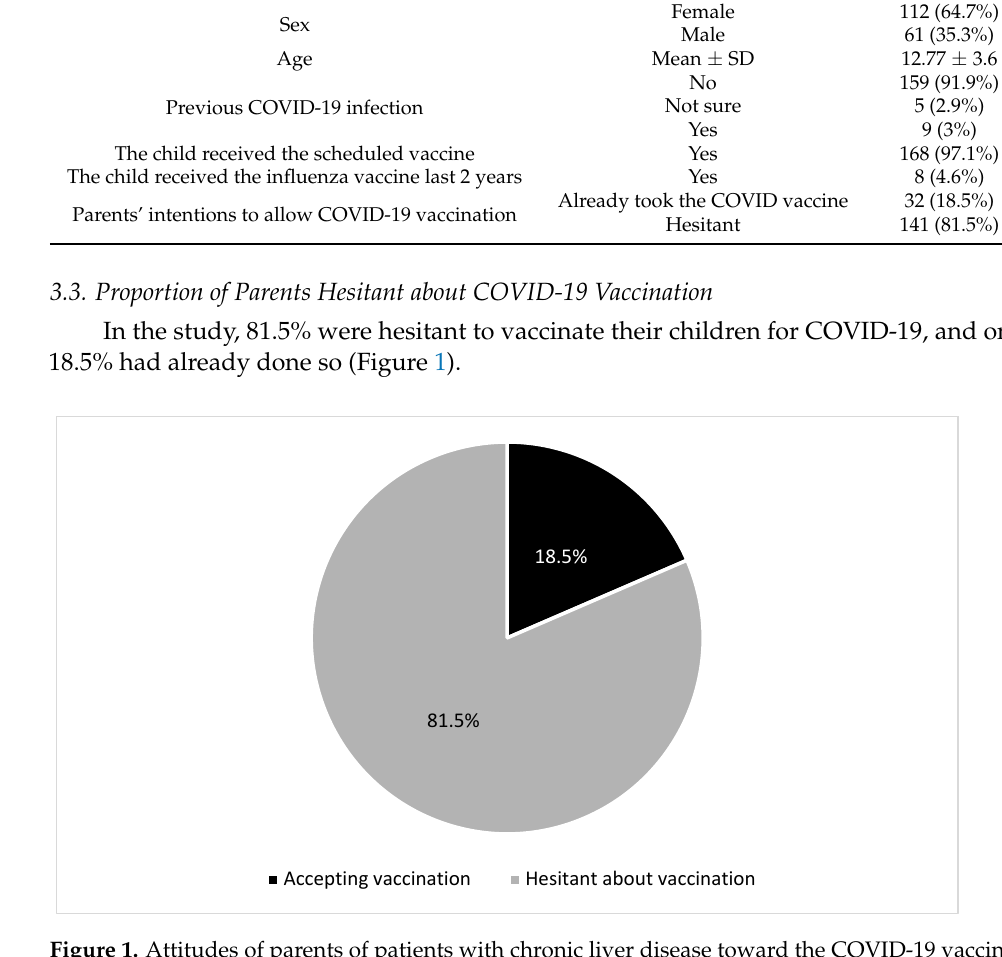
Table 3. Sociodemographic characteristics across vaccinated children.